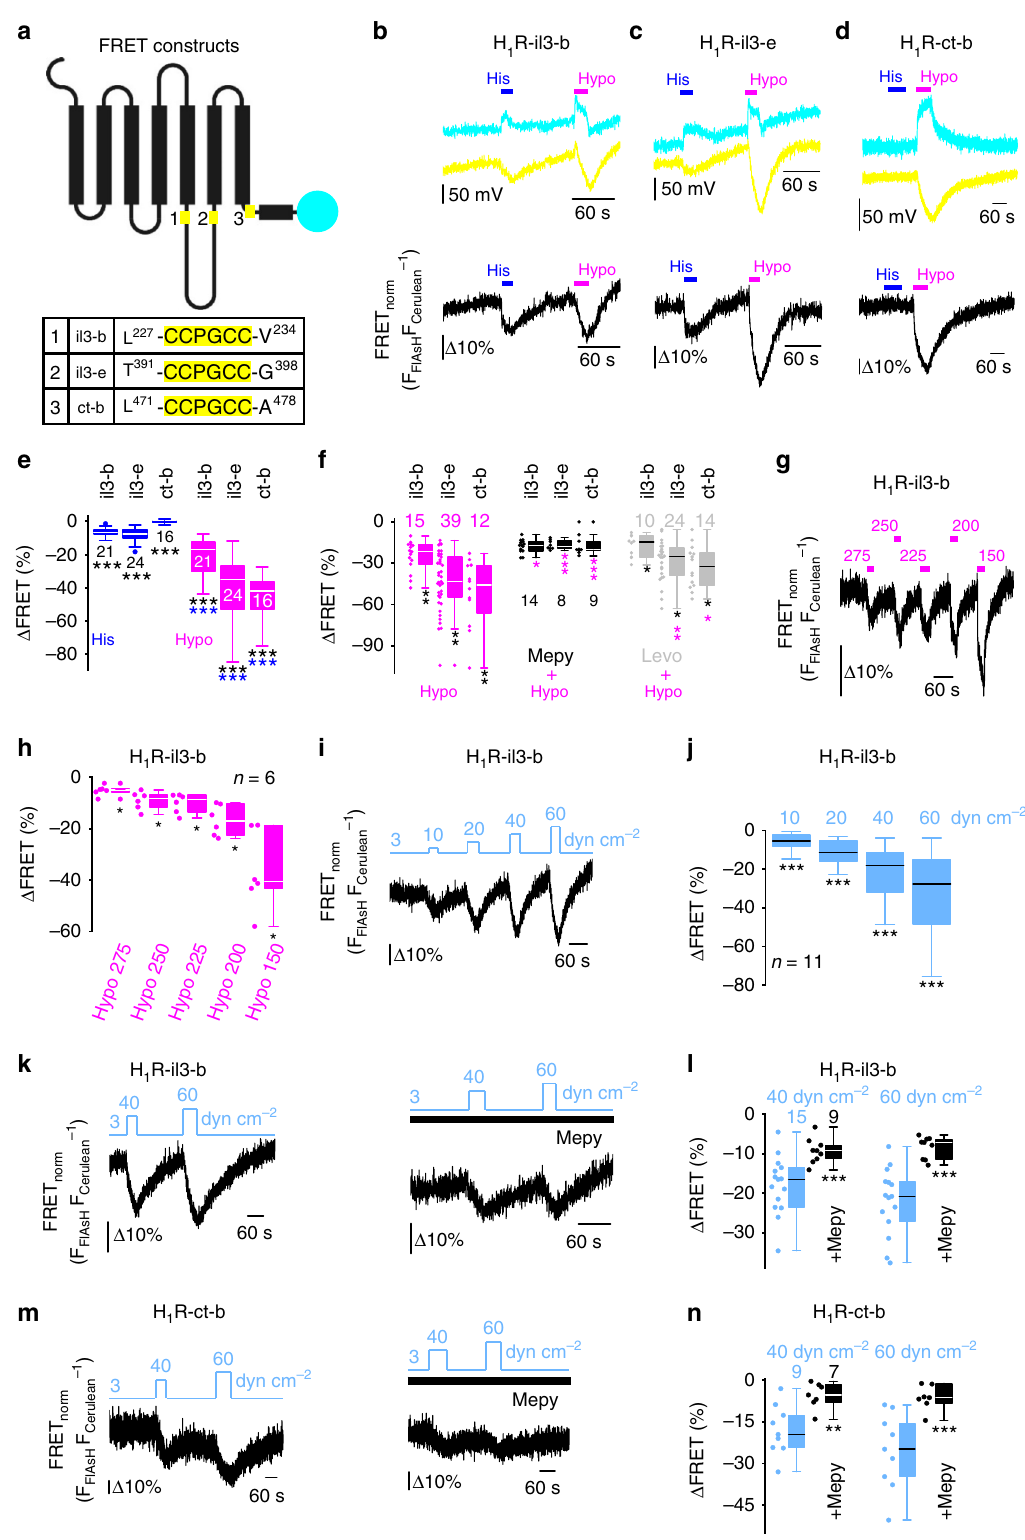
(OAG) – induced current responses did not differ between H 1 R wild-type and H 1 R mutant expressing cells. FRET measurements con fi rmed the loss of agonist sensitivity, while mechanosensitivity was preserved (Fig. 3d – g). There were no differences between mechanically induced FRET decreases of H 1 R wild-type FRET constructs and the corresponding FRET constructs with